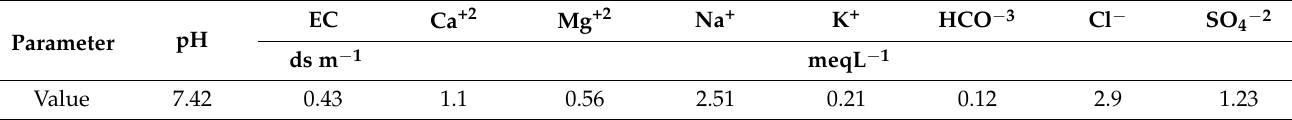
Table 2. Chemical characteristics of irrigation water used for the present